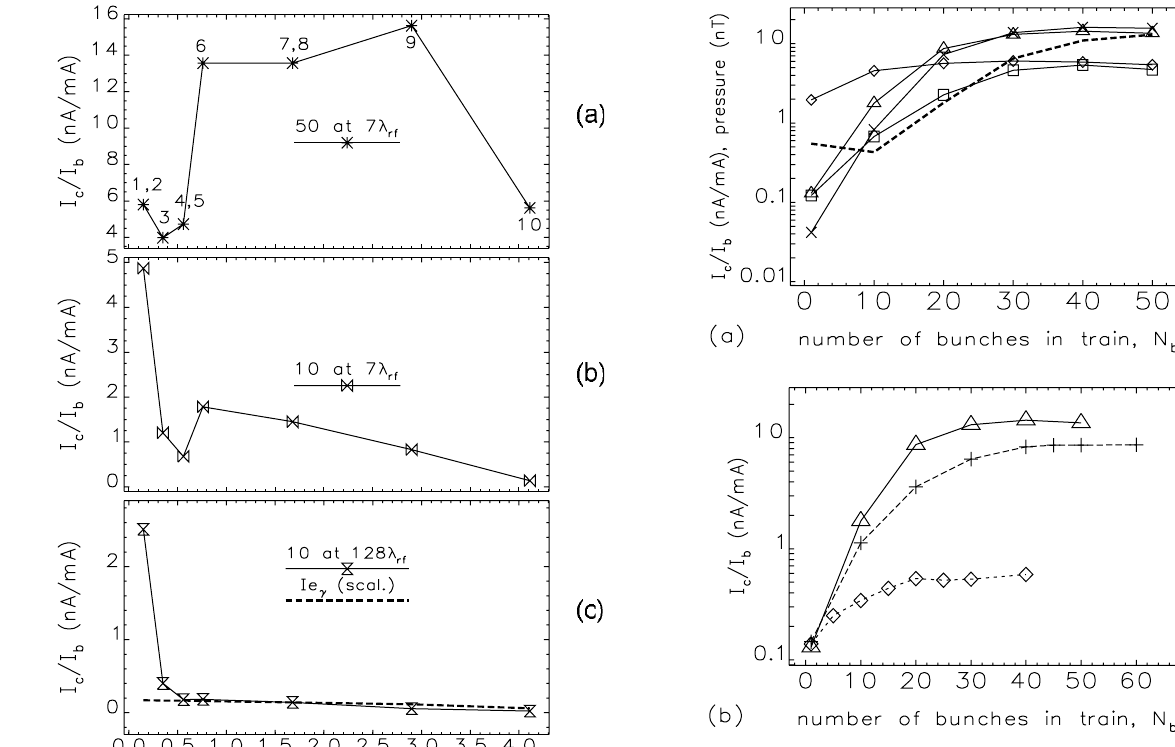
FIG. 11. Growth and saturation of electron cloud over a train . In (a), the data are shown of positron bunches, spaced at 7 (cid:2) rf as a function of detector number (detectors 1, 5, 6, and 9 with 10. Total, normalized electron current per detector as a 2 mA = bunch ). The vacuum pressure P , measured locally, is bunch function of distance from EA for (a) 50 bunches at 7- (cid:2) rf also shown. The vacuum pressure at 100 mA for nominal (non- spacing (detector locations are marked); (b) ten bunches at BIM) operating conditions is 0.5 nT, to be compared with a bunch spacing; and (c) ten bunches at 128- (cid:2) bunch 7- (cid:2) rf rf value of 10 nT for 50 bunches (100 mA) at BIM conditions. The spacing. The beam intensity is 2 mA per bunch. In (c), the bunch train length at which the cloud saturates varies from 10 was estimated, using the calculated photoelectron current Ie (cid:5) to 30 bunches, and the electron-cloud saturation level varies by radiation fans at the detector locations, and scaled to the up to a factor of 5. In (b), detector 6 is shown as a function of data. The normalized signals for 10 or 50 positron 128- (cid:2) rf bunch current; the saturation level varies nonlinearly with show a marked longitudinal dependence bunches spaced at 7 (cid:2) rf bunch compared with case